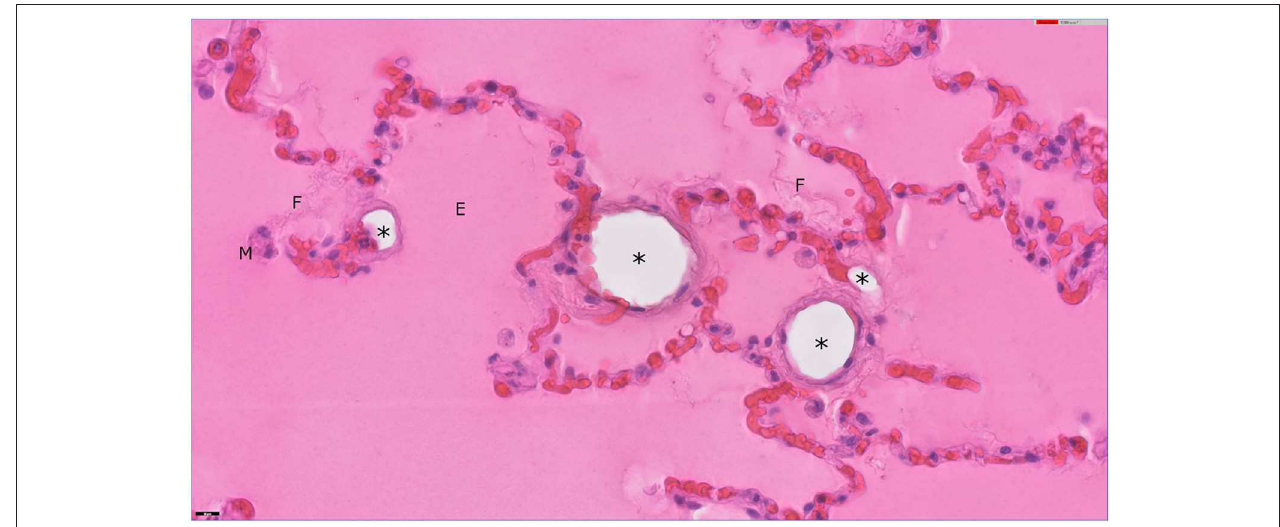
FIGURE 1 | Lung from a dog. Alveoli are filled with eosinophilic, proteinaceous, edema fluid (E) with strands of fibrin (F). A few, foamy alveolar macrophages (M) are present. Several alveolar septa in this field are distended by clear, round, empty spaces (*) that appear to be intravascular and could present extracted lipid emboli. Hematoxylin and eosin stain; bar = 20 µ